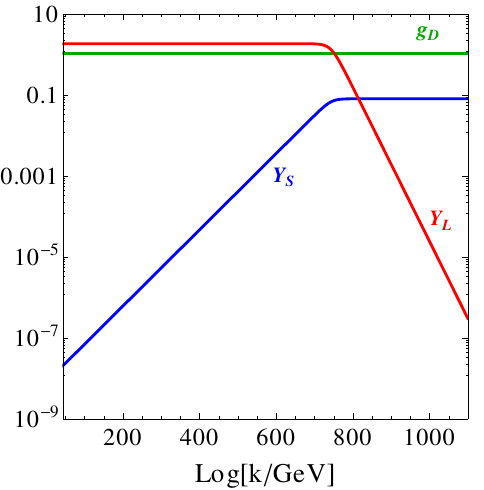
Figure 6. The flow of the NP couplings Y L (solid red), Y S (solid blue) and dark gauge g D (solid green) in the trans-Planckian regime. Gauge charge and AS gravity parameters are set at Q f g = 0 . 0096 , f y = 0 . 00025